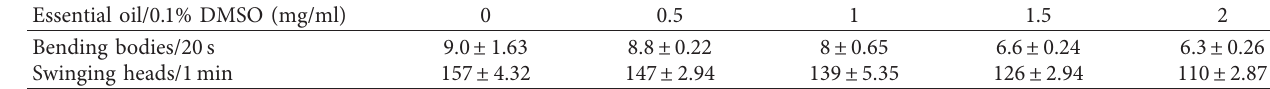
Table 2: Number of body bends and head swings.